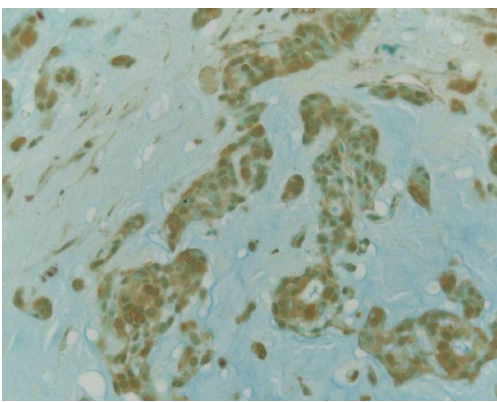
Figure 1: Showing negative nuclear staining of p53 in normal salivary tissue. Original magnification x40.